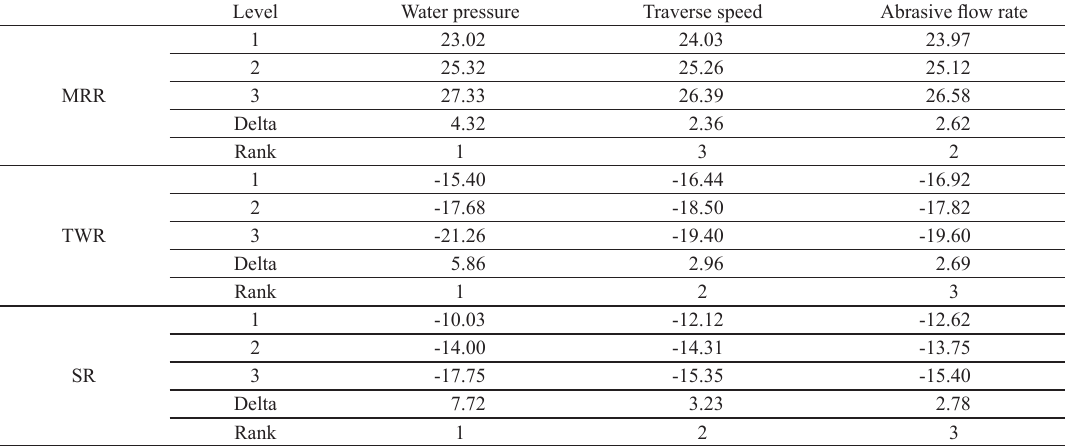
Table 5. Mean of SN ratios for the MRR, TWR and SR